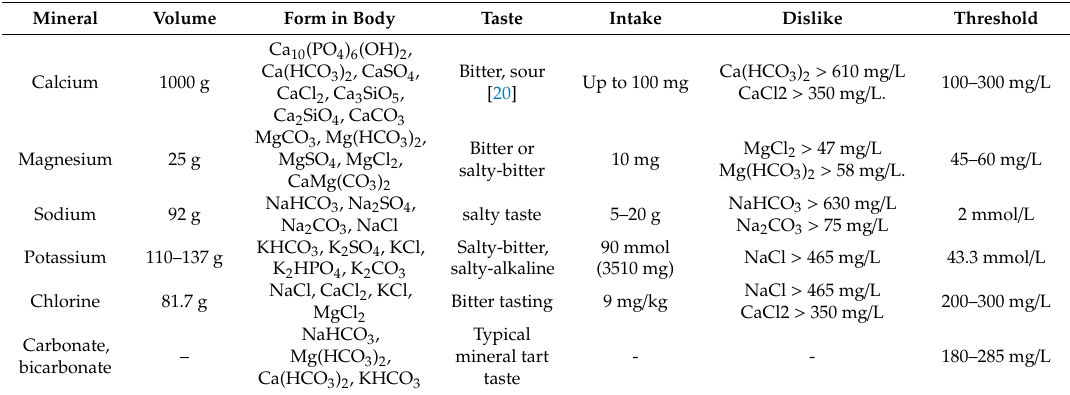
Table 2. Overview of mineral nutrients